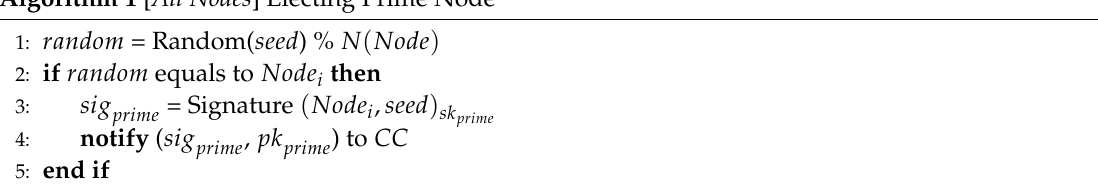
Algorithm 1 [ All Nodes ] Electing Prime Node